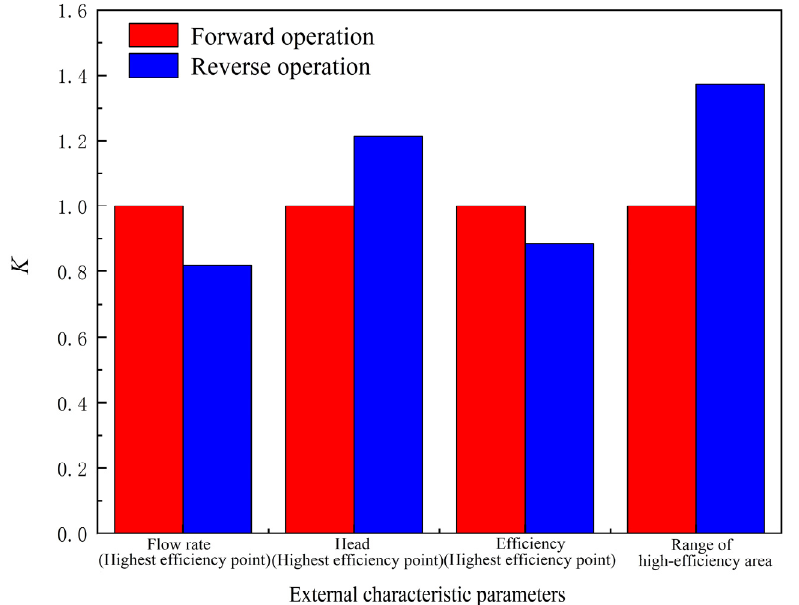
Figure 8. Comparison of energy characteristics between forward and reverse operation conditions based on conversion coefficient.